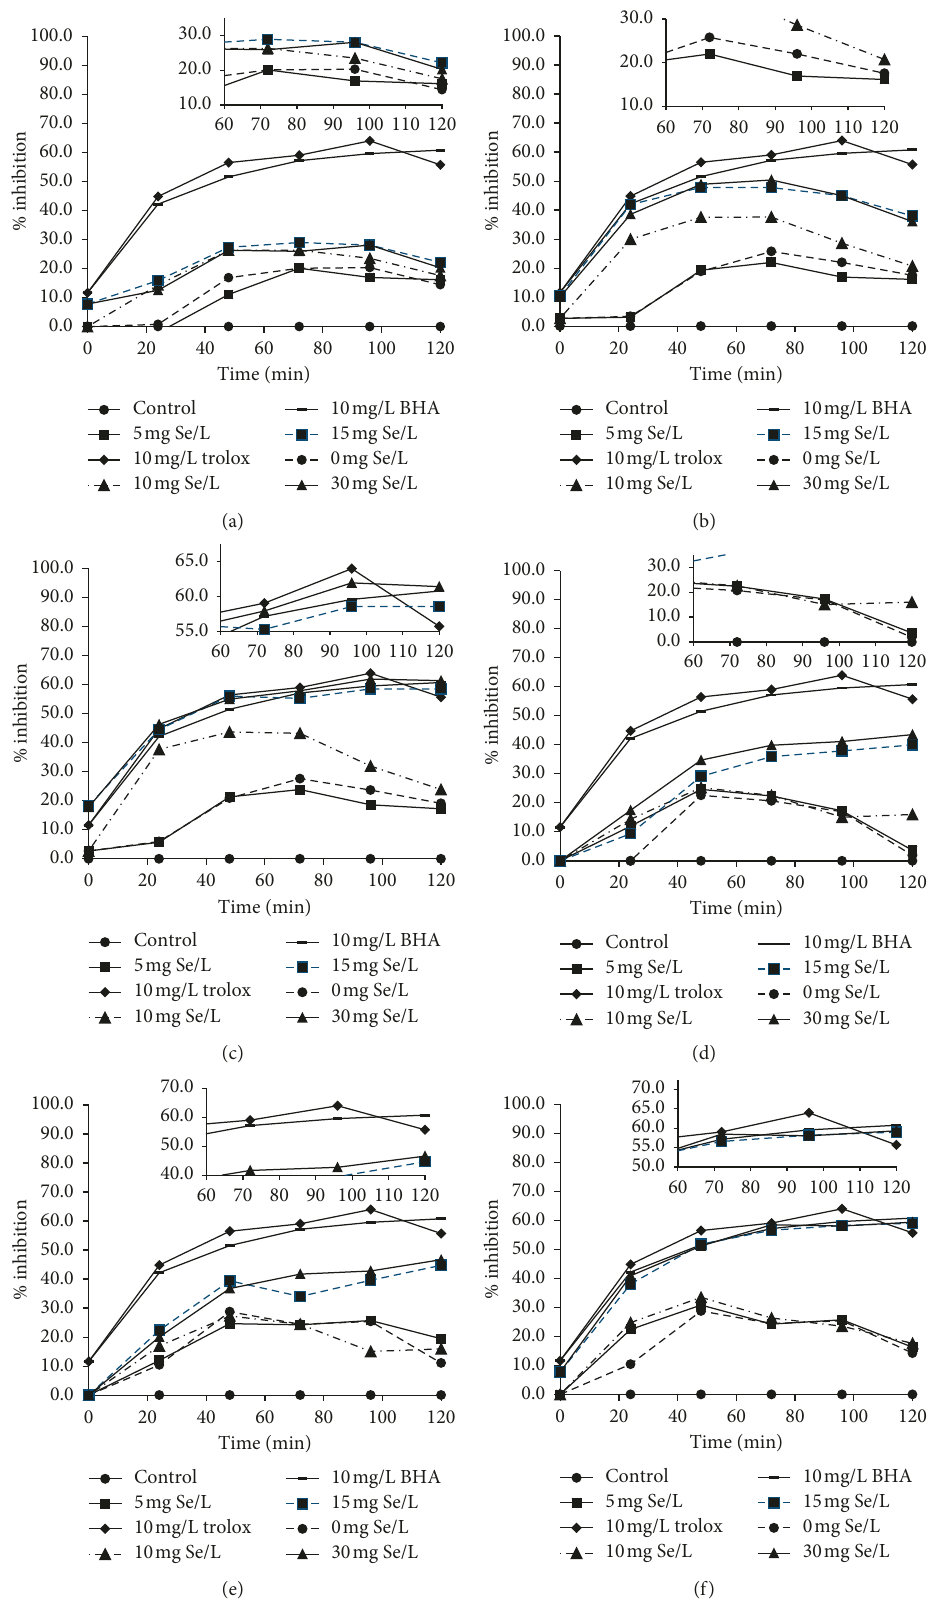
Figure 2: Kinetic behaviors of the ferric thiocyanate method of Se-enriched kale seedlings. The Se-enriched kale seedlings ethanolic extracts (a–c) and aqueous extracts (d–f) with 5 tested Se concentrations and the two reference antioxidants trolox and butylated hydroxyanisol (BHA) in 3 cultivation periods of 5days (a, d), 10days (b, e) and 15days (c, f). The standard represents the blank, the pure ethanol solution and the distilled